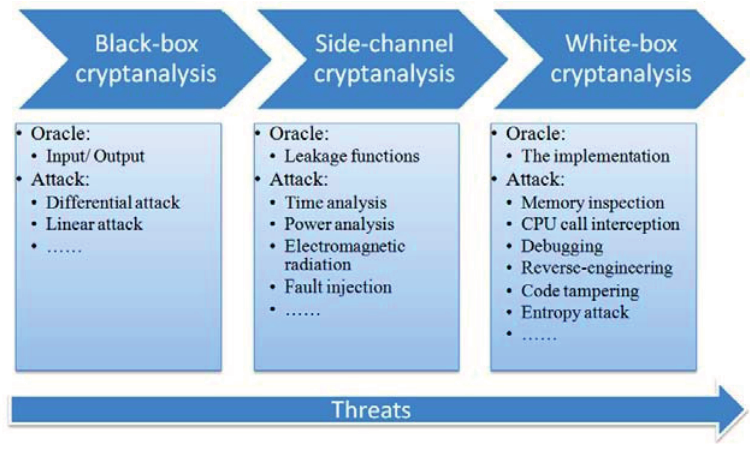
Figure 9. Attack